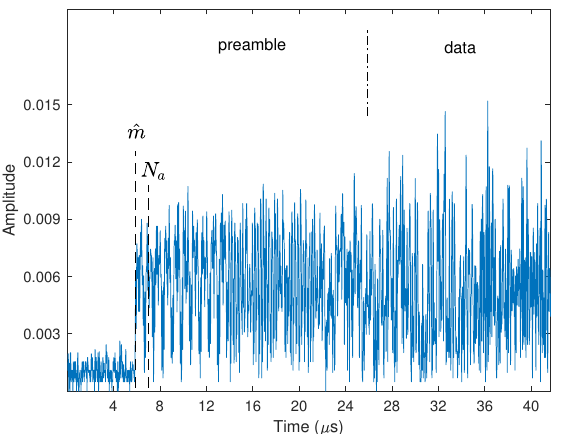
Figure 8. Estimated transient starting point ˆ m and alarm time N a over a long part of a captured Wi-Fi